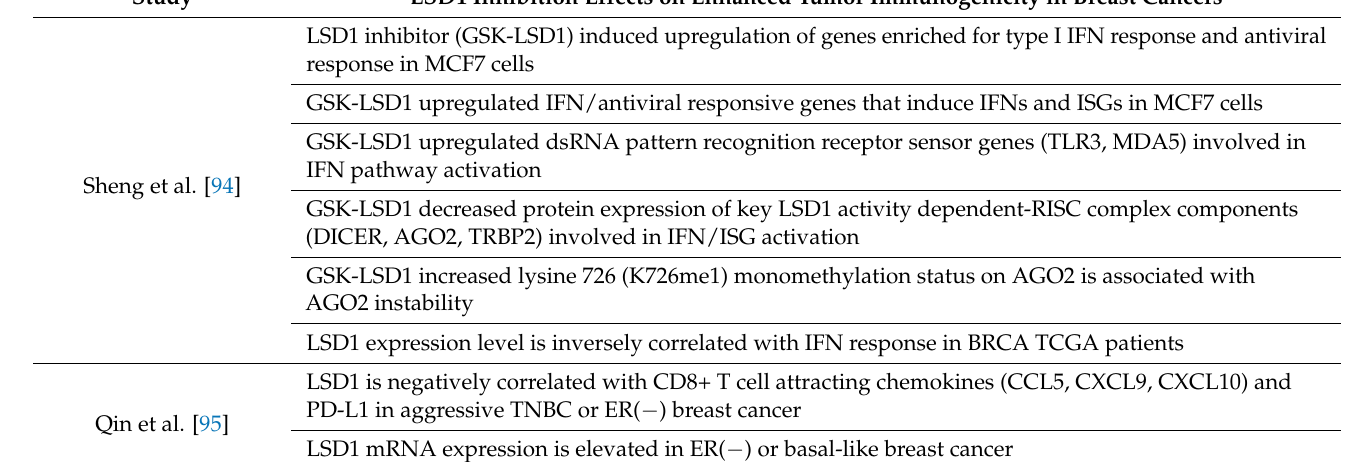
Table 1. List of research studies conducted on LSD1 inhibition effects on tumor immunogenicity in breast